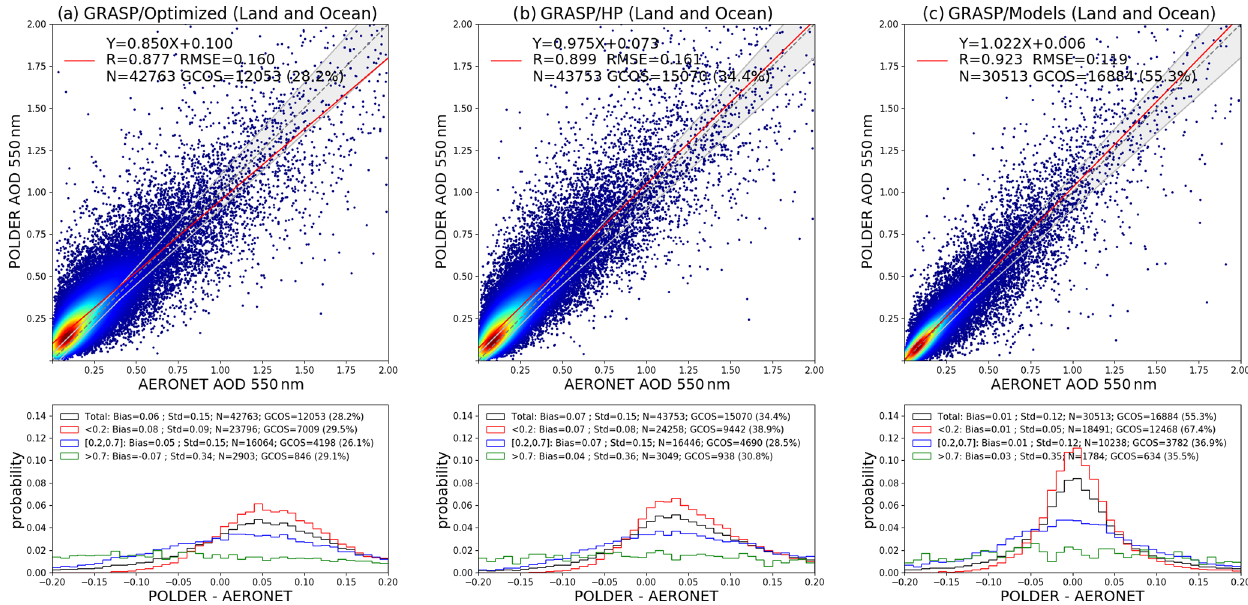
Figure 2. Evaluation of three archives of PARASOL/GRASP AOD at 550nm against AERONET: (a) GRASP/Optimized, (b) GRASP/HP, (c) GRASP/Models. The gray dashed line and the red solid line are the 1 : 1 reference line and the linear regression line. The gray envelope indicates GCOS requirement: max (0.04 or 0.1AOD). The probability density functions of differences (POLDER-AERONET) are present in the lower panel. The black, red, blue and green solid lines indicate all AOD conditions: any AOD, AOD < 0.2, 0.2 ≤ AOD ≤ 0.7 and AOD > 0.7, respectively. Table 4. Global statistics of PARASOL/GRASP AE vs. AERONET AE (440 / 870) over land and ocean. The best performing of three approaches by each metric is labeled in bold. R Slope Offset RMSE Bias Land Optimized (18594) 0.797 0.680 0.213 0.358 − 0.10 HP